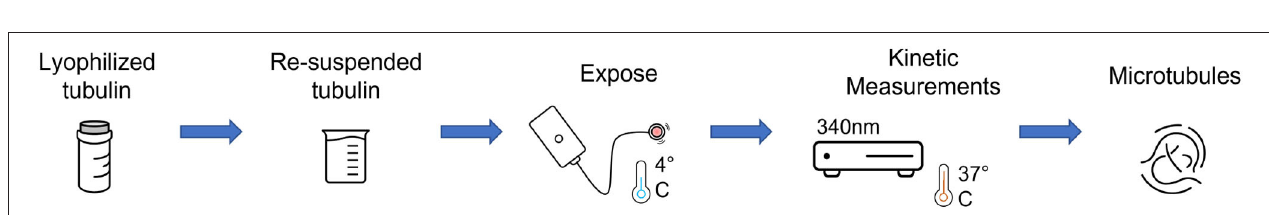
FIGURE 9 | A schematic of the experimental procedure used for turbidity measurements of the Vielight LED-exposed tubulin samples.